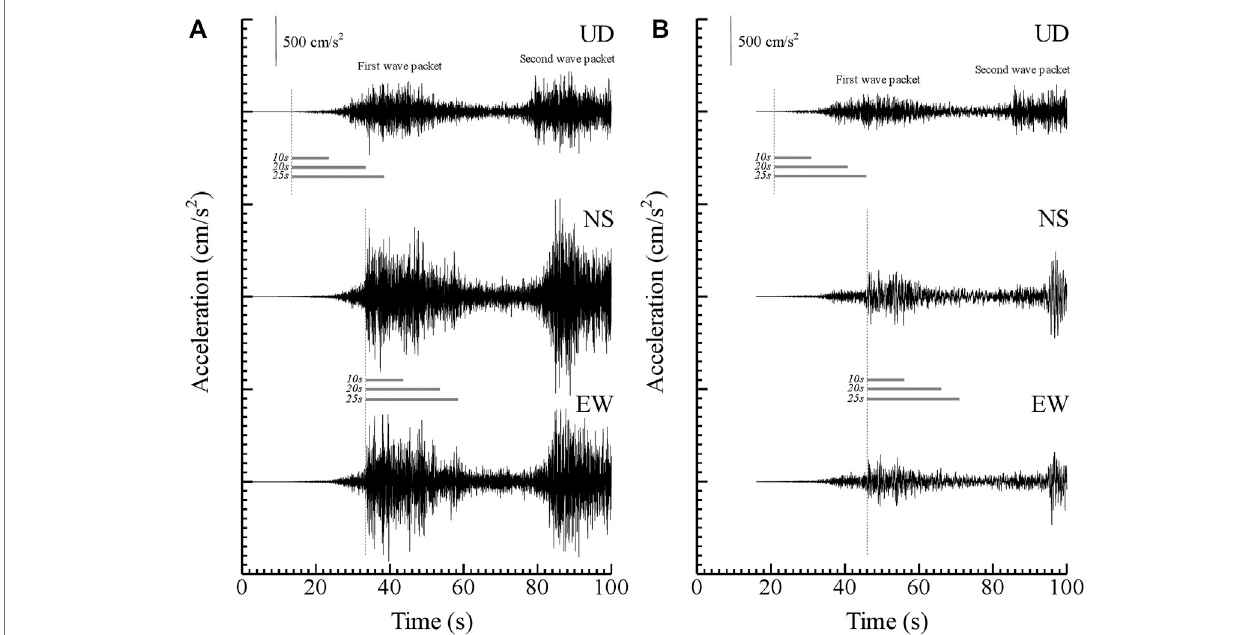
FIGURE 11 | Waveforms of acceleration for 3 components during the 2011 off the Paci fi c coast of Tohoku earthquake ( Mw 9.0) occurred on 11th/March 2011 observed at KS and SS stations. Broken lines show onsets of P-wave for UD component and S-wave for NS and EW components. Under lines show time-windows of 10,20,and25 sforeachcomponent.The fi rstandsecondwavepacketaregeneratedbydifferentthestrongmotiongenerationareas(SMGAs)estimatedbyAsanoand Iwata (2012). (A) KS station (B) SS station.